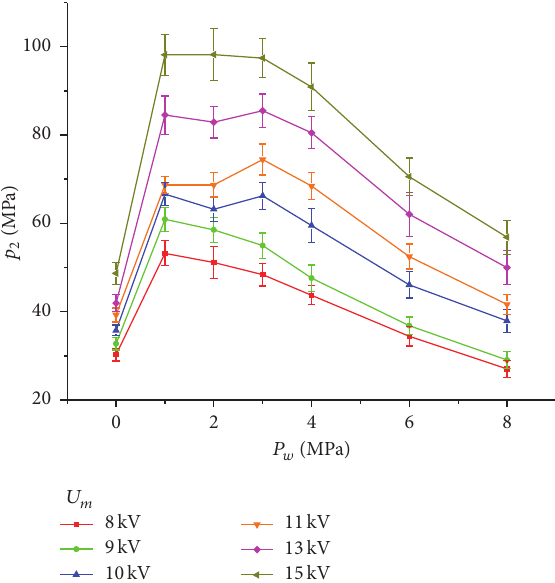
Figure 12: Peak pressure ( 𝑝 2 ) of the reflection shock wave measured at 2.5 m from